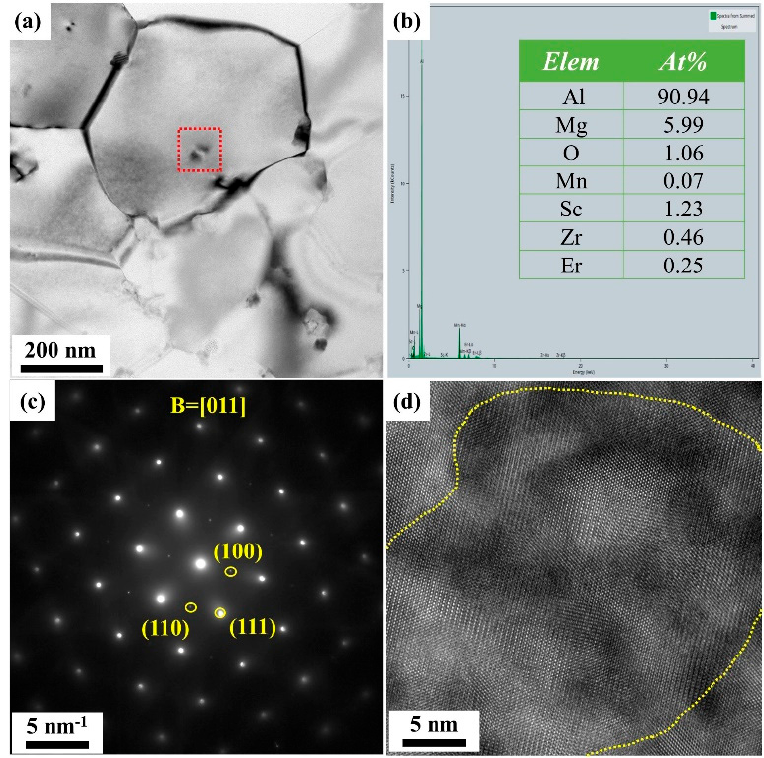
Figure 8. TEM images of primary Al 3 (Sc, Er, Zr) in as-built sample: ( a ) BF-STEM image of the FG region; ( b ) EDX results; ( c ) SAED; ( d ) HR-TEM.